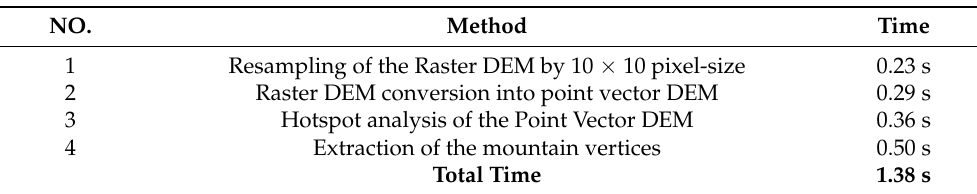
Table 14. The time consumed in extracting mountain vertices for the fourth dataset using our proposed